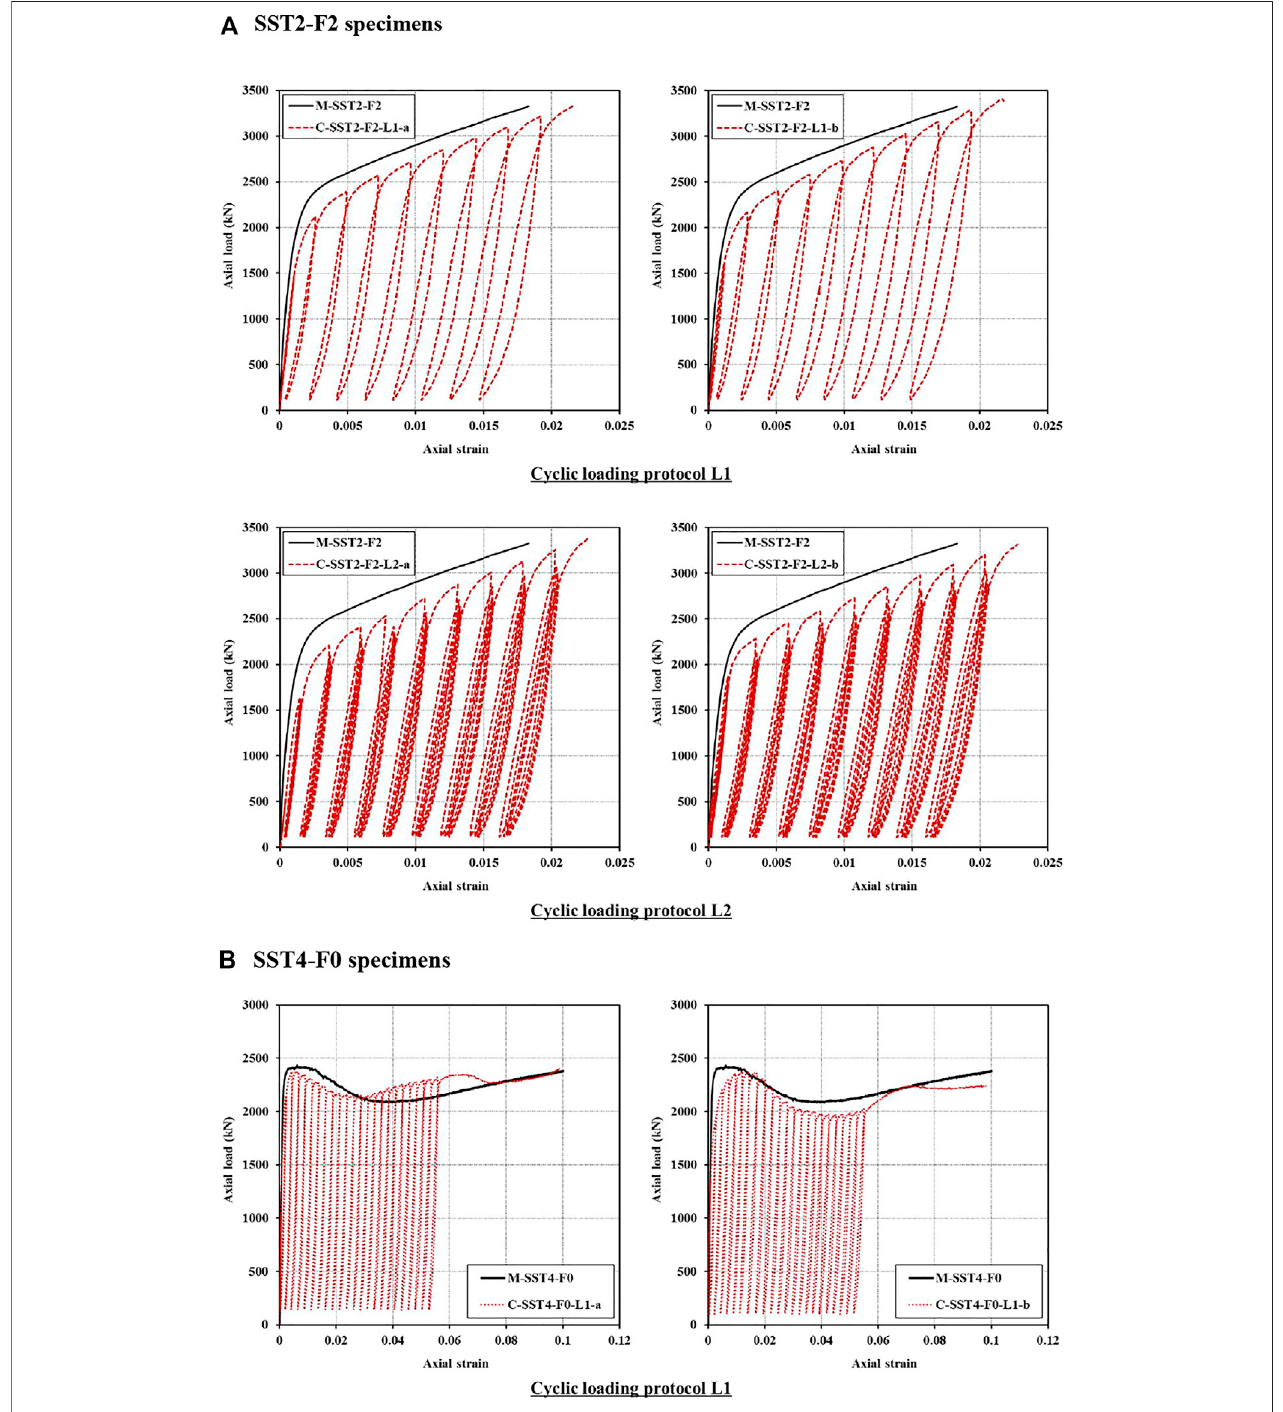
FIGURE 5 | Axial load – strain curves. (A) SST2-F2 specimens. (B) SST4-F0 specimens. (C) SST4-F2 specimens. (D) SST4-F4